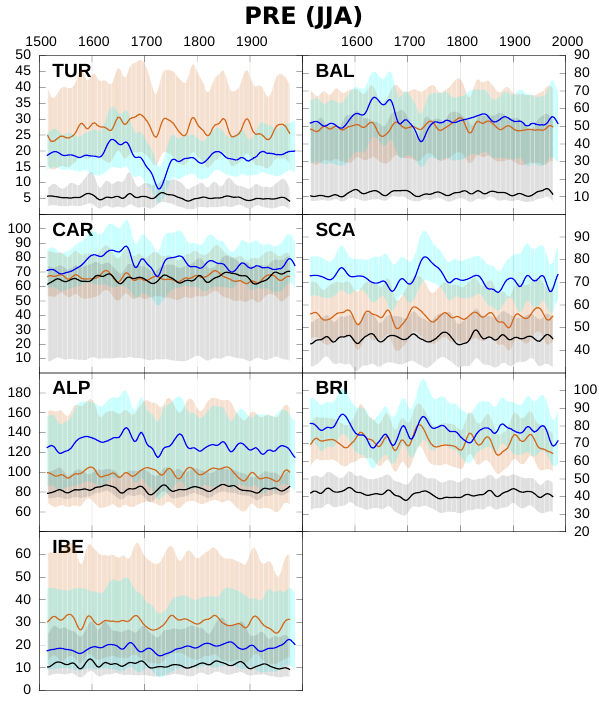
Figure 5. As Fig. 4 but for summer PRE.